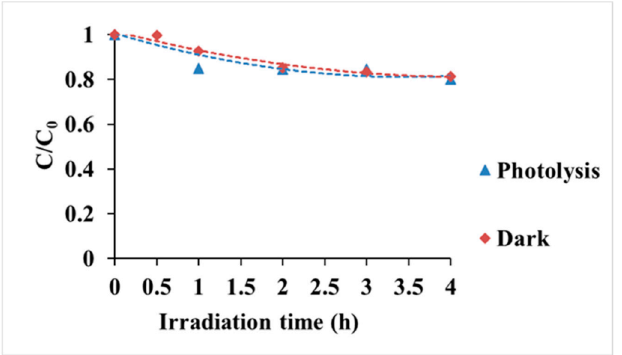
Figure 8. Dark effect with TiO 2 /ZnO/CuPc photocatalyst, and photolysis influence on the degrada- tion of IBF (C 0 = 5 mg/L, pH =